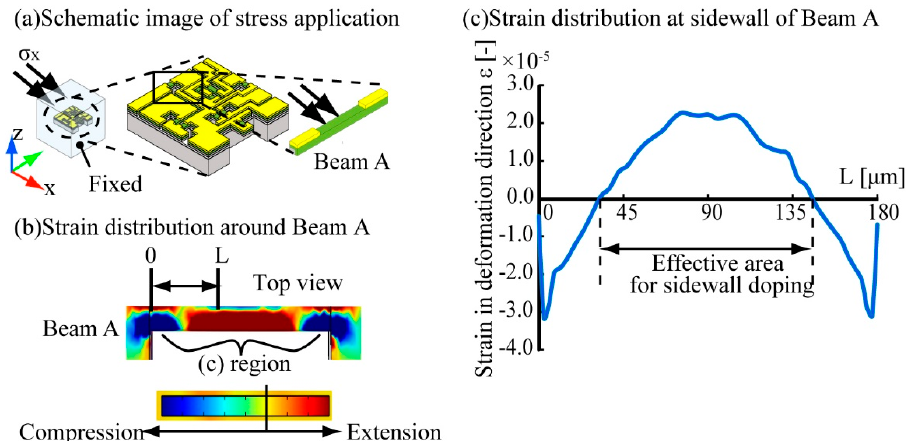
Figure 3. Finite element method (FEM) simulation of normal stresses. ( a ) schematic image of applying an x direction normal stress, ( b ) strain distribution around Beam A in response to σ x , and ( c ) strain distribution around the sidewall of Beam A.